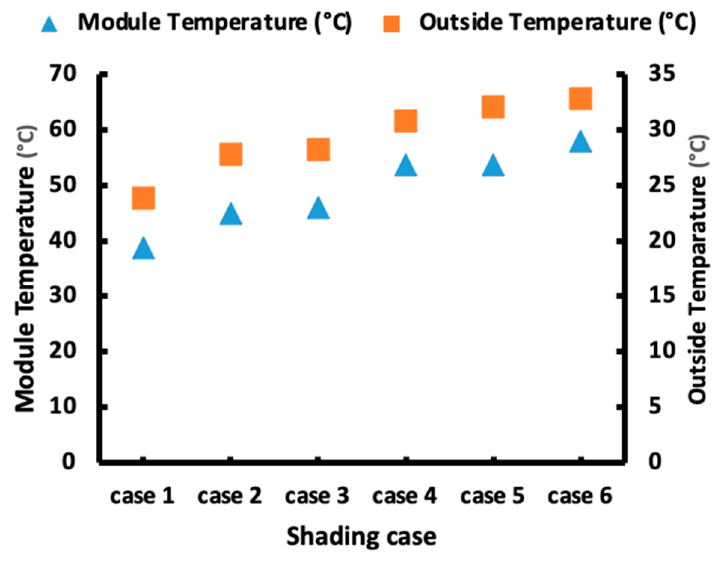
Figure 8. The effect of six different PSCs on PV array A modules’ temperature.